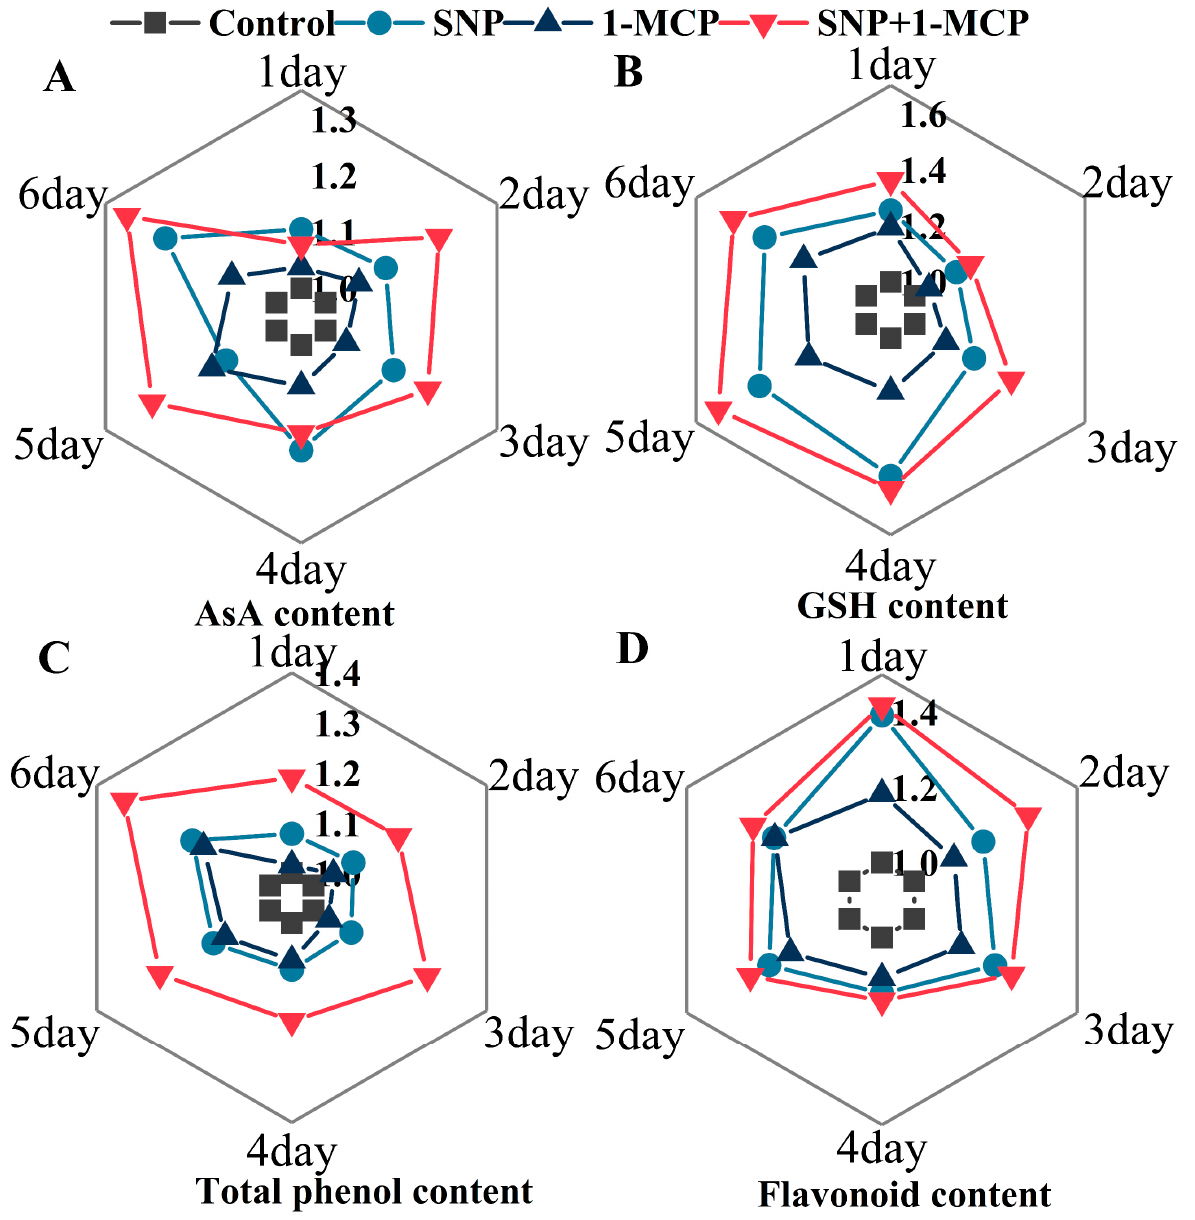
Figure 5. ( A ) Ascorbic acid (AsA), ( B ) glutathione (GSH), ( C ) total phenol, and ( D ) flavonoid contents of Agaricus bisporus at 25 °C.